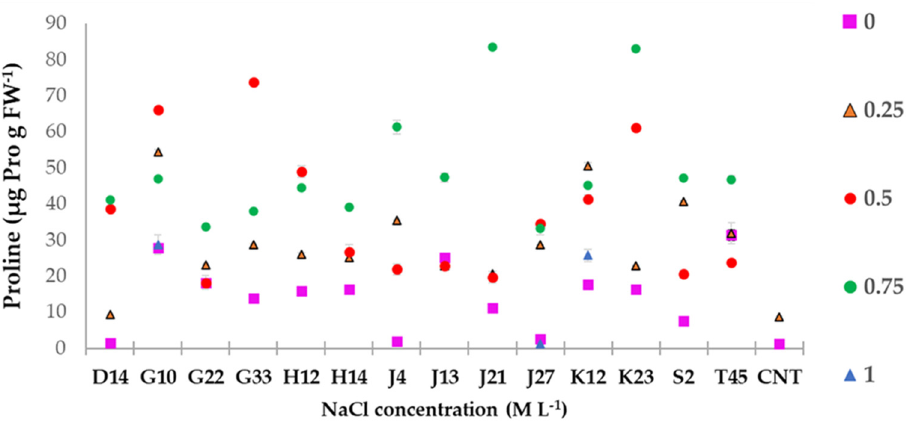
Figure 6. Proline content estimated in shoots of inoculated and uninoculated plants without (0 M NaCl) and with salt stress induction (0.25 M, 0.5 M, 0.75 M, 1 M NaCl) (n = 3). Without salt stress, there is an accumulation of proline in plant shoots. The inoculated plants have a higher proline value than the uninoculated ones (no PGPB/no salt stress), with variable accumulations depending on the strain (p < 0.05, Figure S4A). Salt stress caused a significant proline increase in plants. Inoculated plants had a higher accumulation of proline in response to the increasing NaCl concentrations. At 0.25 M NaCl, the highest proline contents were recorded in plants inoculated with strains S. iakyrus G10, S. xantholiticus K12, and N. aegyptica S2 with an average of 49 µ g.g − 1 FW (+ 460%, p < 0.05, Figure S4B) compared to the stressed control (no PGPB/salt stress). At higher NaCl, the proline concentration gradually increased in all inoculated plants. At 0.5 M NaCl, plants inoculated with S. iakyrus G10 and G33 accumulated 70 µ g Pro g FW − 1 (p < 0.05, Figure S4C). The highest proline accumulation was recorded at 0.75 M (83 µ g Pro g − 1 FW) in plants inoculated with N. alba J21 and S. thinghirensis K23 (p < 0.05, Figure S4D). For strains S. iakyrus G10, S. ambofaciens J27, and S. xantholiticus K12—the only ones that induced plant halotolerance up to 1 M NaCl—moderated amounts of proline were detected (<30 µ g Pro g − 1 FW). The lowest values were obtained for S. ambofaciens J27 (p < 0.05, Figure S4E). To explore potential correlations between the outcomes of in vitro and in planta experiments, the data were processed by the Principal component analysis (PCA). Figure 7 shows the PCA biplot obtained from the 0 M NaCl L − 1 condition. According to the correlations, shoot length, AFDW, and proline accumulation were associated with the production of NH 3 and HCN, root length and chlorophylls with IAA production and phosphate solubilization, and root AFDW with ACC deaminase activity. These associations under salt stress conditions changed (Figure 8) and at 1 M NaCl L − 1 , the ACC deaminase activity, IAA production, and phosphate solubilization had a good association with proline accumulation and salt stress tolerance (chlorophylls and roots and shoots length and AFDW). The different correlations between in vitro and in planta results demonstrate that the in vitro approach could be useful for the selection of isolates with biostimulating and halotolerant